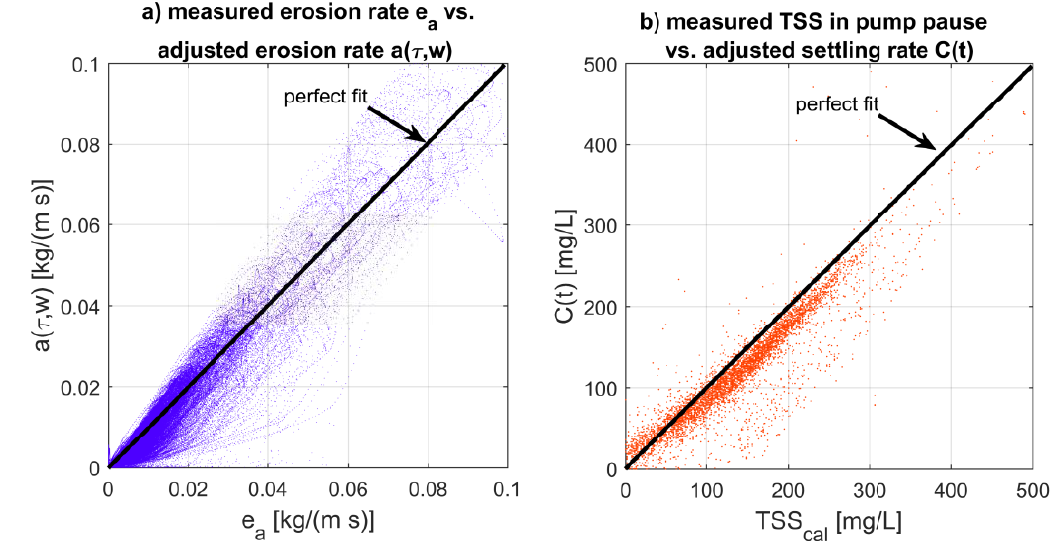
Figure 5. Evaluation of the erosion and settling approximation. ( a ) All measured erosion rates e a vs. all mathematical approximations by a ( τ , w ). ( b ) All measured settling events inside the pipe vs. all mathematical approximations by C ( t ).